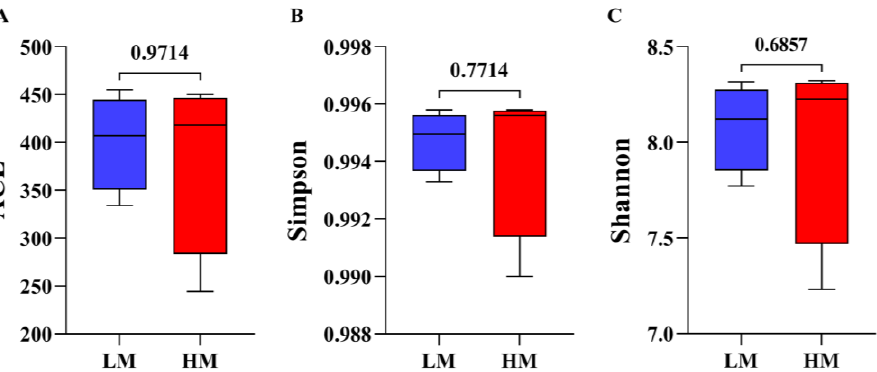
Figure 3. Alpha-diversity analysis of gut microbial community structure in LM and HM groups ( A ) ACE index: ( B ) Simpson index, ( C ) Shannon index. Red represents the HM group; blue represents the LM group. LM, low − motility group; HM, high − motility group.